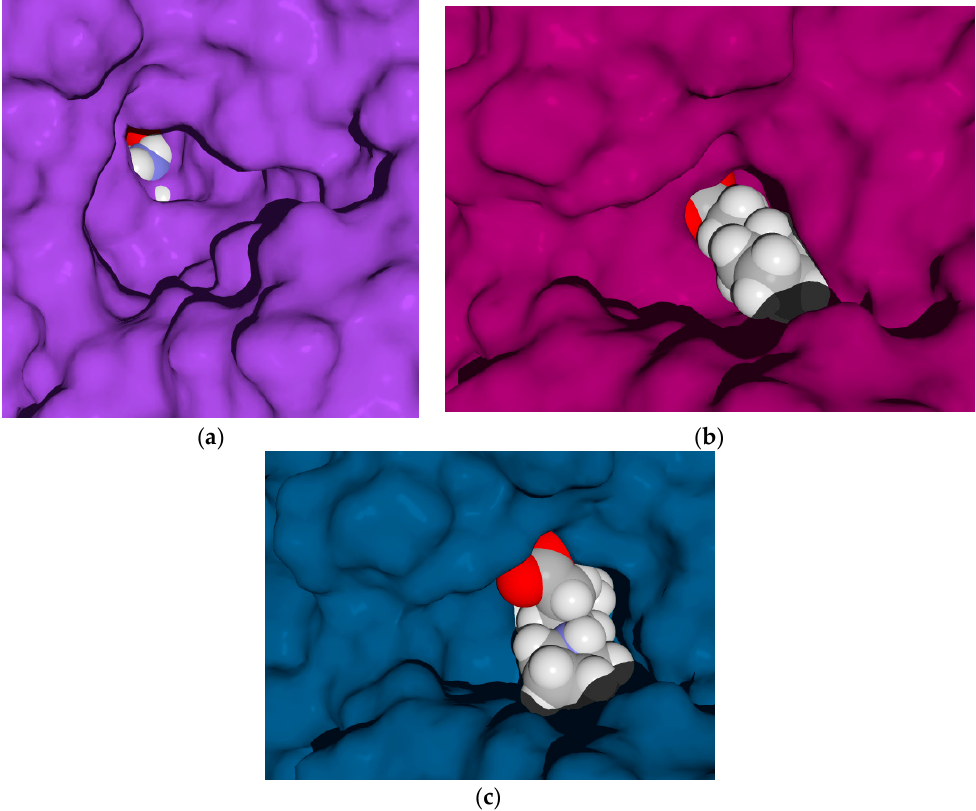
Figure 12. ( a ) Molecular surface of the catalytic site of Pseudomonas GABA-AT (purple color). PLP prosthetic group is shown as a spacefill model; ( b ) Molecular surface of Pseudomonas GABA-AT (pink color) interacting with 9a (spacefill model); ( c ) Molecular surface of Pseudomonas GABA-AT (blue color) interacting with 19a (spacefill model).